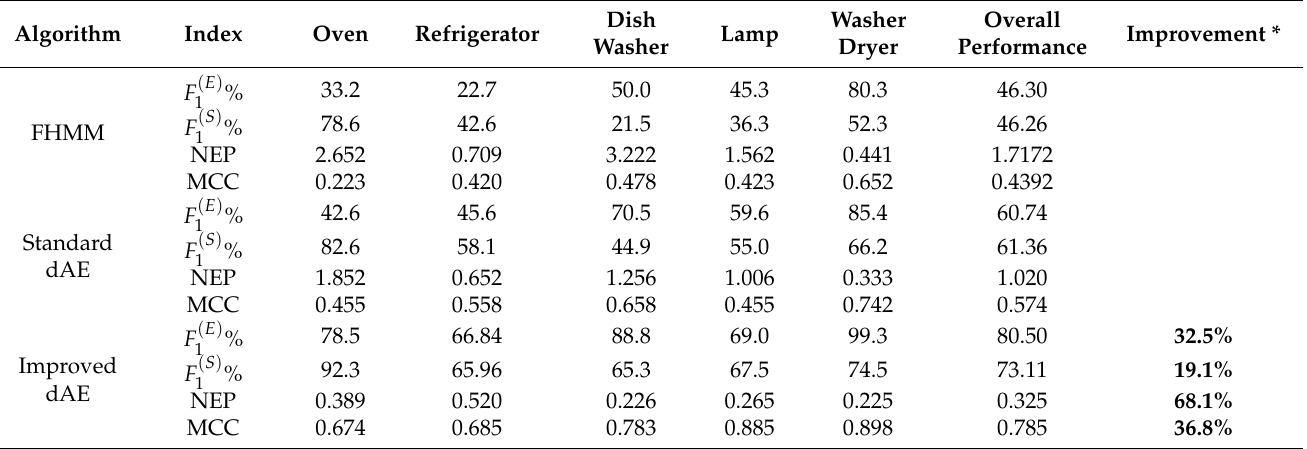
Table 1. Comparison of identification indexes of several equipment using REDD